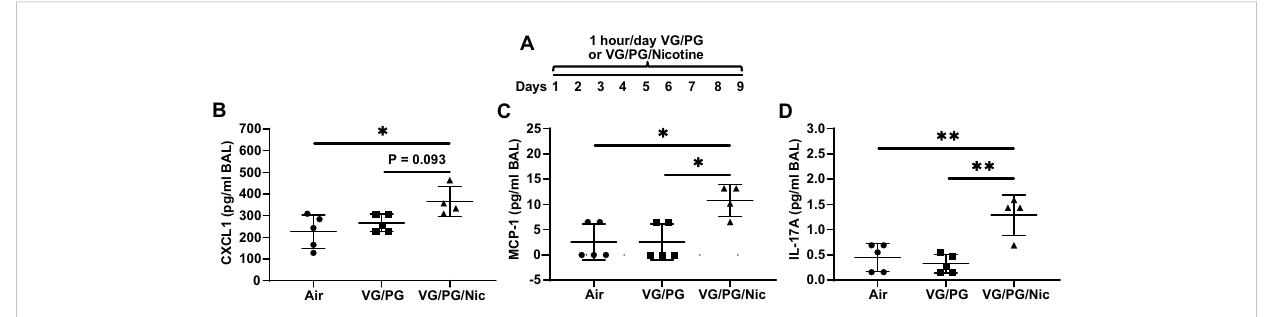
FIGURE 2 Nicotine-containing e-cigarette aerosol elicits an in fl ammatory response in the airspaces. (A) Timeline of e-cigarette exposures. (B – D) CXC motif chemokine ligand 1, CXCL1 (B) , monocyte chemoattractant protein-1, MCP-1 (C) , and interleukin-17A, IL-17A (D) , were signi fi cantly greater in the bronchoalveolar lavage (BAL) from mice exposed to nicotine-containing aerosol (VG/PG/Nic) than in mice exposed to only VG/PG (i.e., the carrier) or to air, suggesting a nicotine-speci fi c effect. * P < 0.05, ** P < 0.01, 1-way ANOVA with Tukey ’ s multiple comparisons test. Data are presented in picogram/milliliter (pg/ml). Each data point represents one